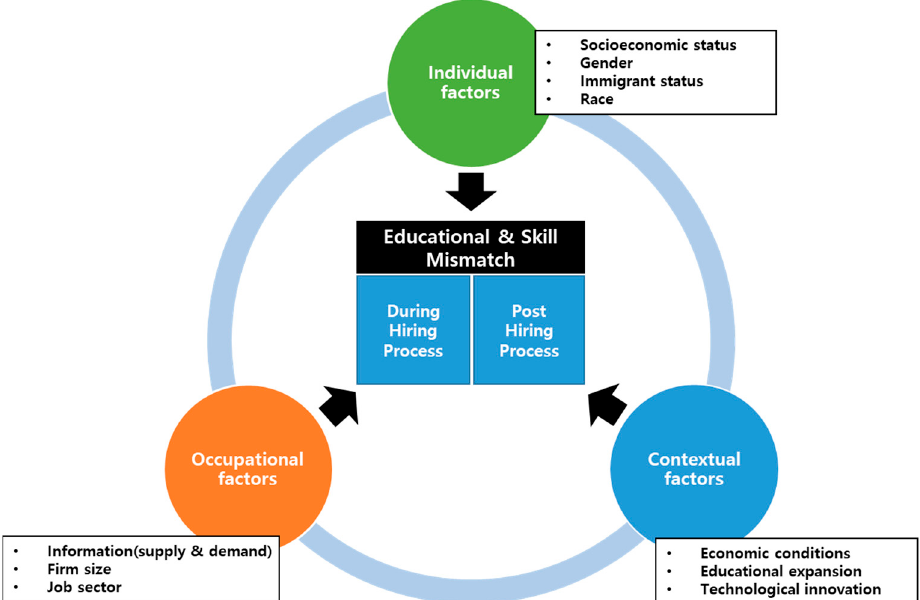
Figure 1. The mechanisms of producing educational and skill mismatch.